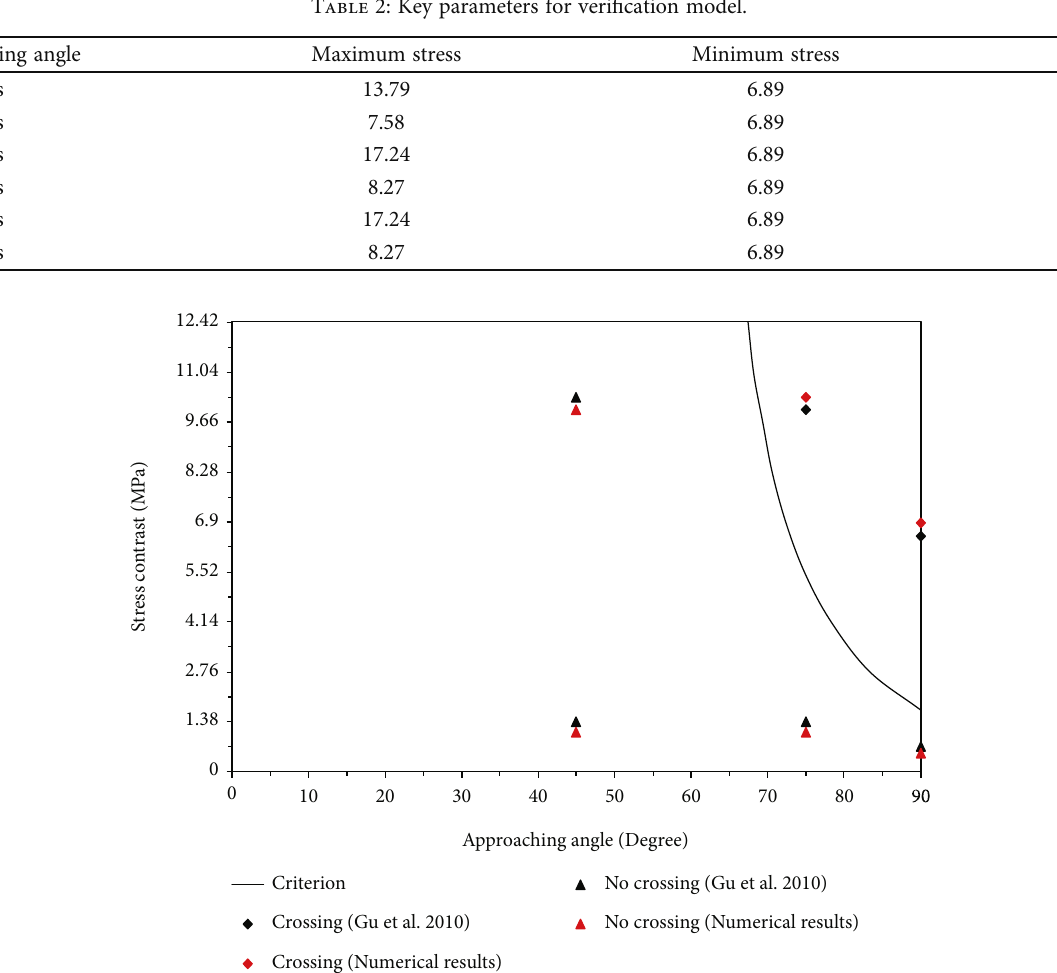
Figure 5: Comparison results between fi nite element model and Gu et al. ’ s